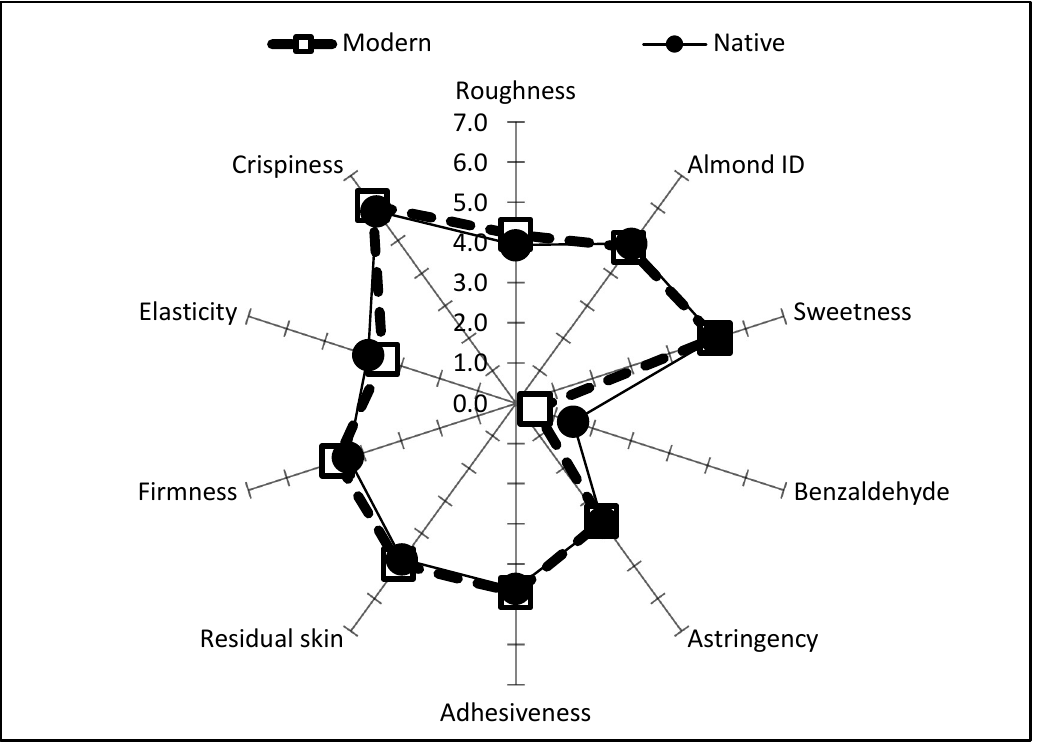
Figure 5. Sensory profile of the modern versus native almond cultivars.